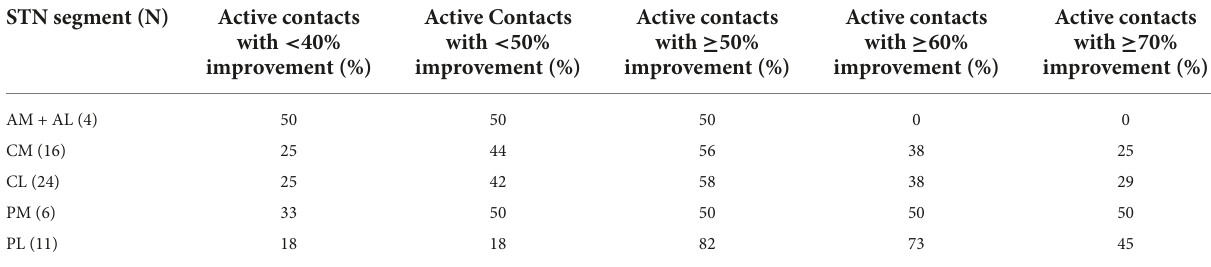
TABLE 2 Percentage of active stimulated contacts at increasing motor improvement defined in each subthalamic nucleus (STN) segment when contacts are located fully or partially inside the STN